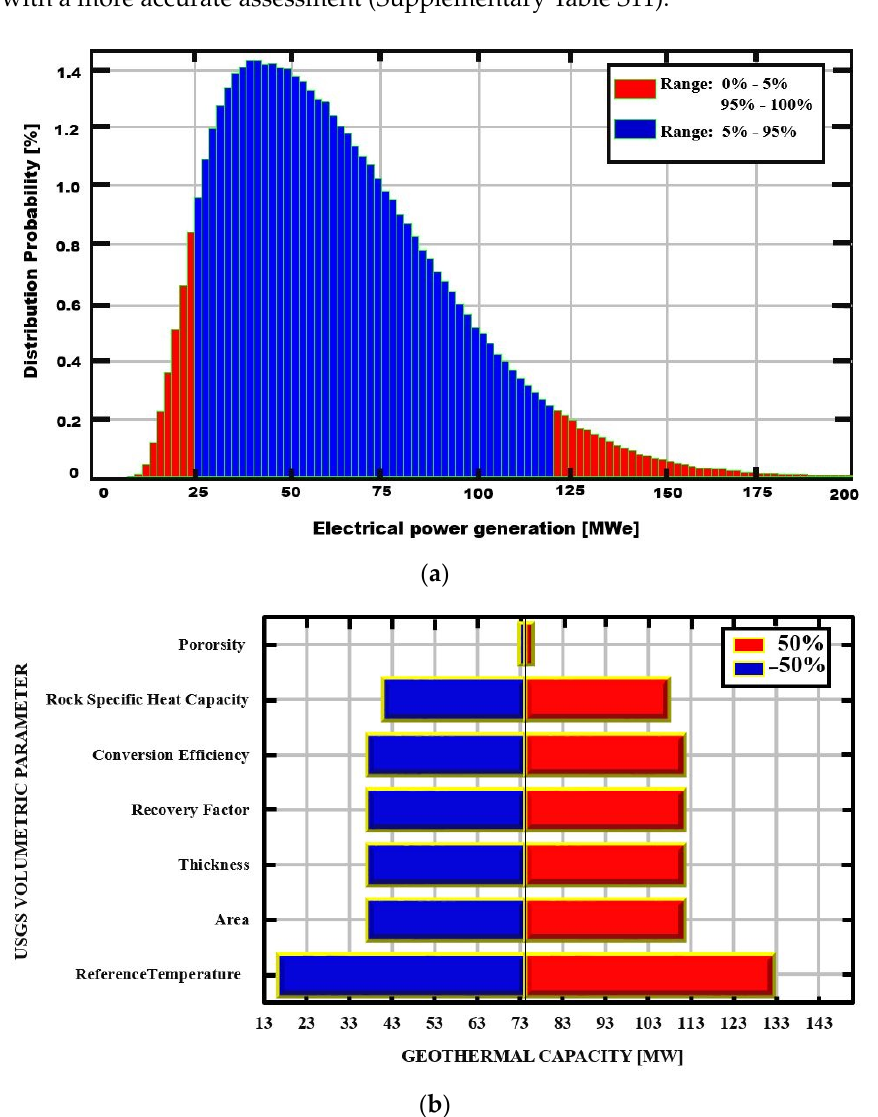
Figure 8. ( a ) Probability distribution of Monte Carlo simulation and ( b ) Tornado diagram for sensitivity result of volumetric parameters.